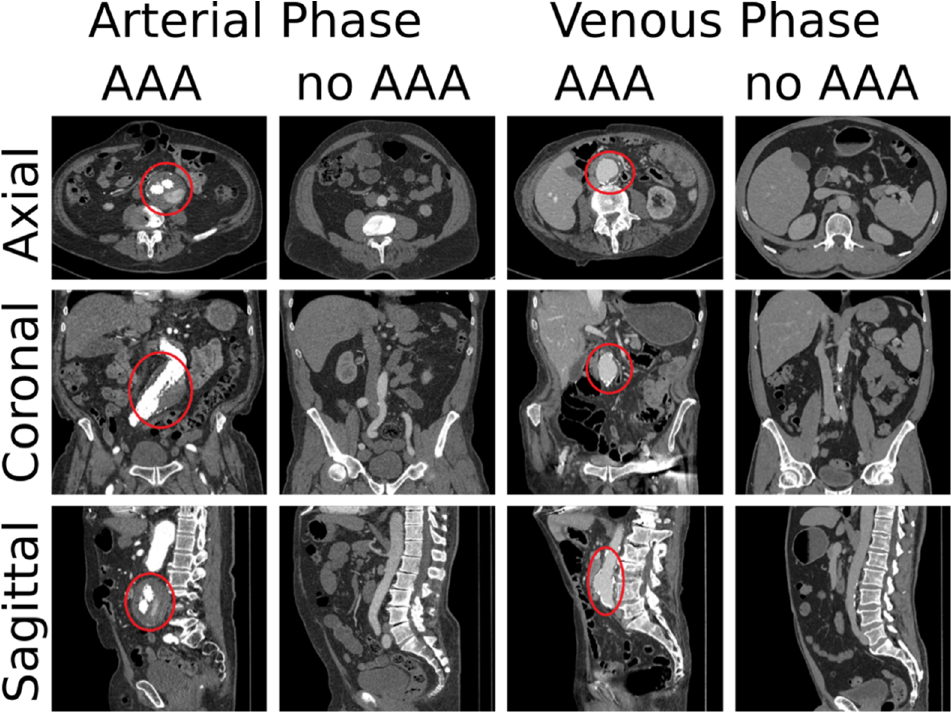
Figure 1. Four example cases from our training data set. For each case one slice of each principal anatomical plane is shown. The location of the AAAs is marked with a red circle. Table 1. Data set statistics.